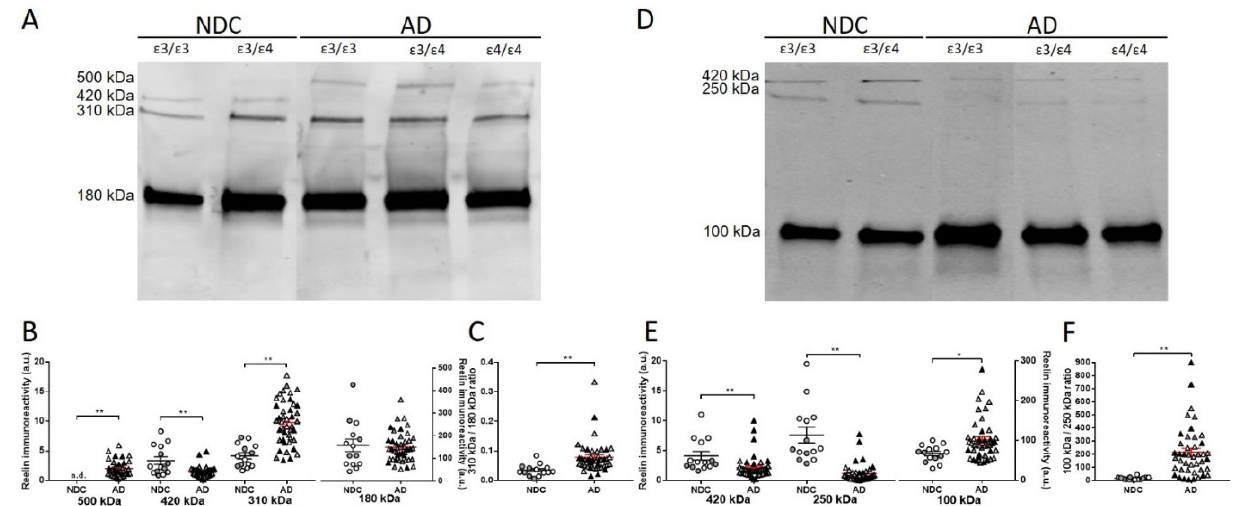
Figure 2. Characterization of reelin immunoreactive bands in CSF samples. ( A ) Representative blots of the reelin species detected in NDC and AD CSF samples using the N-terminal antibody. A species with a molecular mass of ~500 kDa was detected only in AD samples, together with the full-length species of 420 kDa and the 310 and 180 kDa proteolytic N-terminal fragments present in all the samples. ( B ) Densitometric quantification of the individual immunoreactivities of each reelin immunoreactive band detected with the N-terminal antibody. ( C ) Graph of the quotient obtained by dividing the level of immunoreactivity of the 310 kDa N-terminal fragment by the 180 kDa N-terminal fragment (310 kDa/180 kDa quotient). ( D ) Representative blot of reelin species immunoreactive to a C-terminal antibody in the CSF samples. ( E ) Densitometric quantification of reelin immunoreactivity from the 420 kDa full-length species and the 250 kDa and 100 kDa C-terminal fragments. ( F ) The ratio derived from the immunoreactivity for the 100 kDa C-terminal fragment with respect to the 250 kDa C-terminal fragment estimated in each sample (100 kDa/250 kDa quotient) is also shown. The samples are represented by the disease condition (NDC: circles; AD: triangles) and APOE genotype: APOE ε 3/3 (white); APOE ε 3/ ε 4 (grey); and APOE ε 4/ ε 4 (black). There were 14 NDC subjects (9 APOE ε 3 (7 APOE ε 3/ ε 3 and 2 APOE ε 3/ ε 2) and 5 APOE ε 3/ ε 4) and 41 AD subjects (15 APOE ε 3/ ε 3, 13 APOE ε 3/ ε 4, and 15 APOE ε 4/ ε 4). The data represent means ± SEM. * p < 0.05; ** p < 0.001; n.s. = nonsignificant; and n.d. = not detected. Graphs of comparisons between AD CSF samples subgrouped by APOE genotype are included as Supplemental Figures S2 and